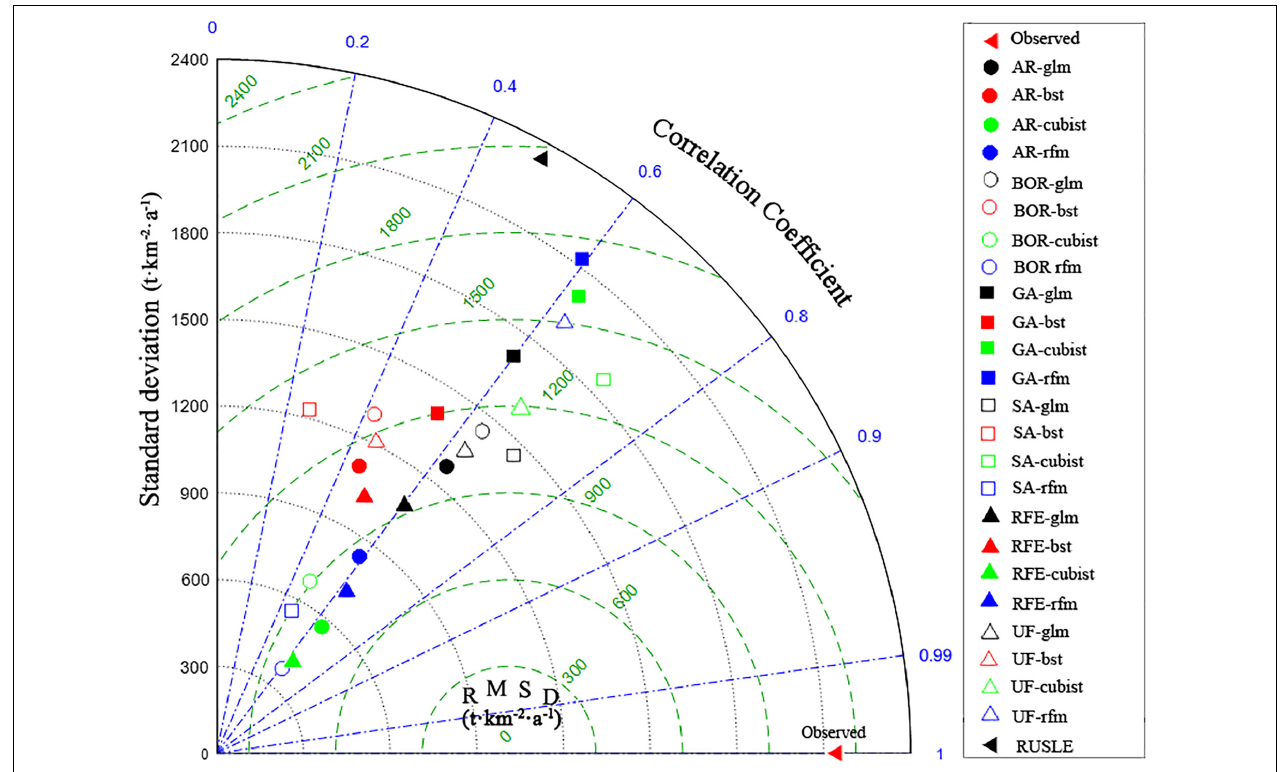
FIGURE 3 | Performance of RUSLE (revised universal soil loss equation model) and 24 machine learning models at the site level. “Observed” on the x -axis means the statistical information of the observed dataset. AR, all relevant; BOR, Boruta all-relevant; SA, simulated annealing; GA, genetic algorithm; RFE, recursive features elimination; UF, univariate filters; GLM, generalized linear model; cubist, cubist model; RFM, random forest model; BST, boosting tree model; RUSLE, revised universal soil loss